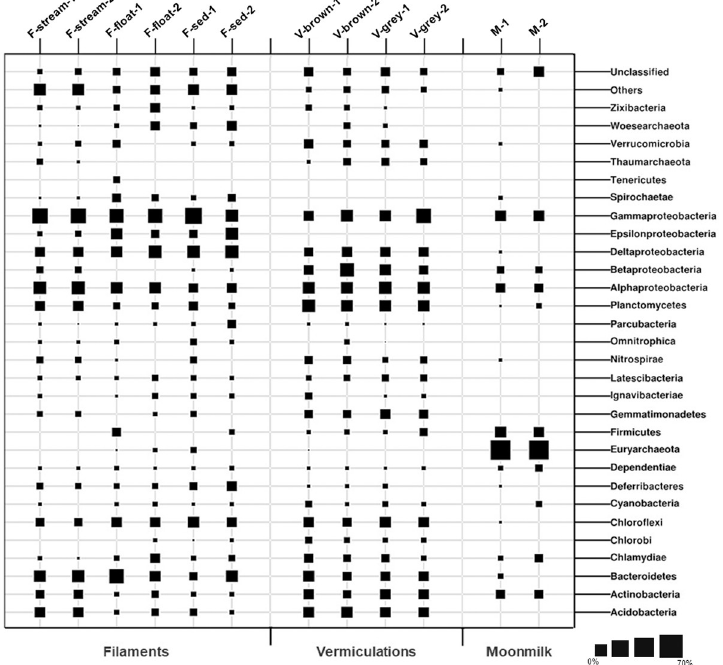
Fig 6. Microbial community composition at phylum/proteobacteria class level of Fetida Cave samples representing water filaments, vermiculations and moonmilk deposits. Microbial phyla and proteobacterial classes with abundance < 1% are included in “Others” (S1